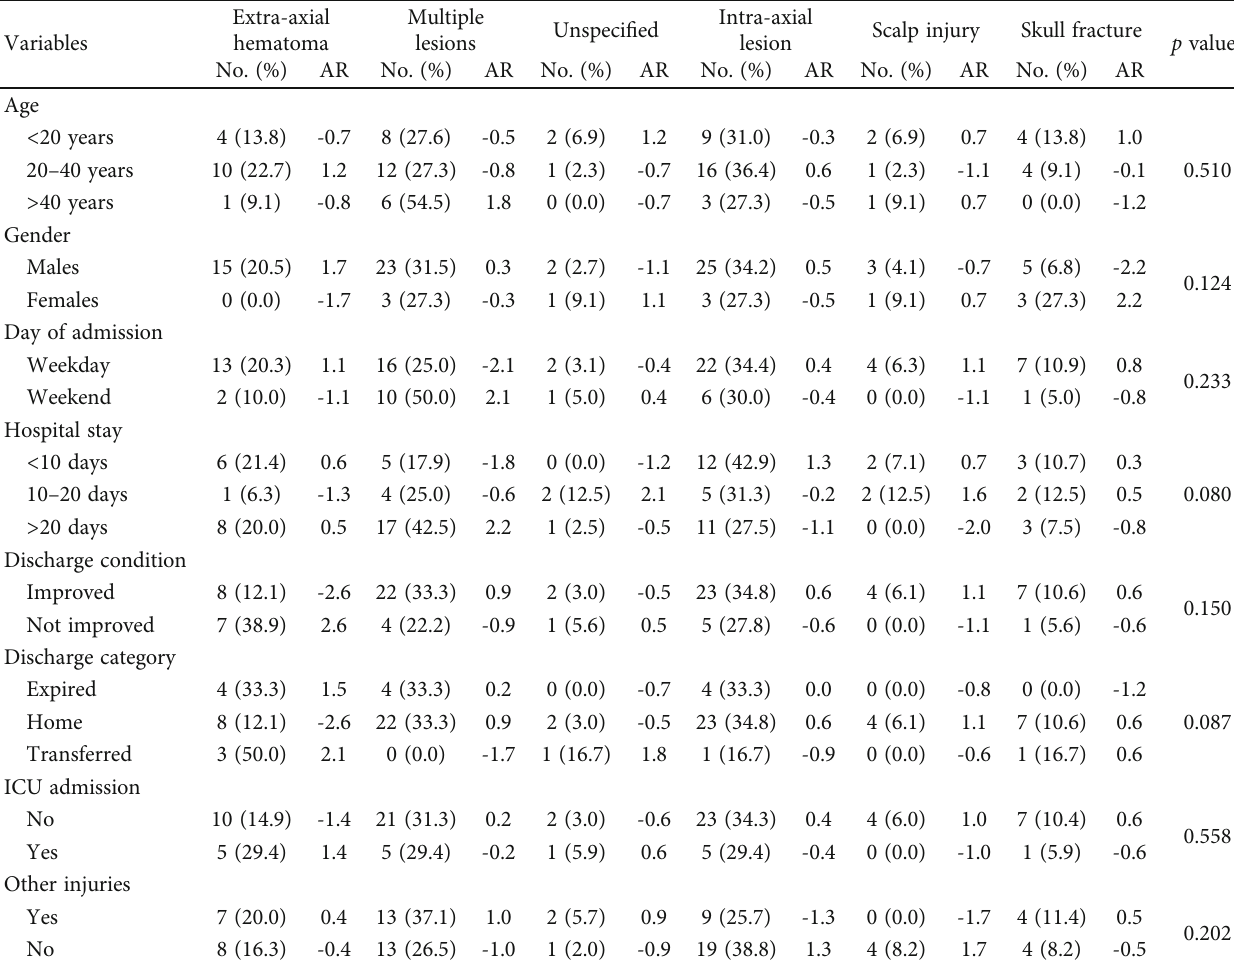
Table 4: Association between the di ff erent variables and types of head injuries ( n = 84